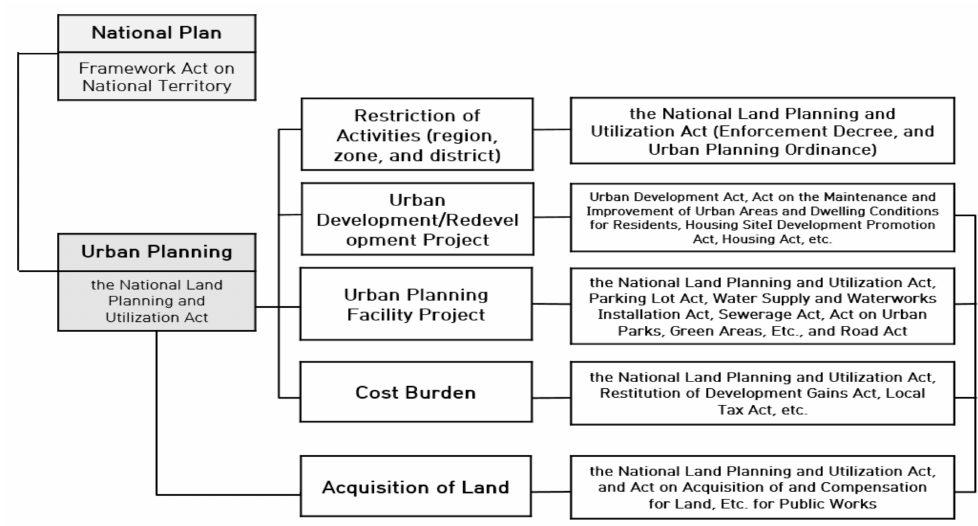
Figure 3. The structure of urban development-related laws [35].